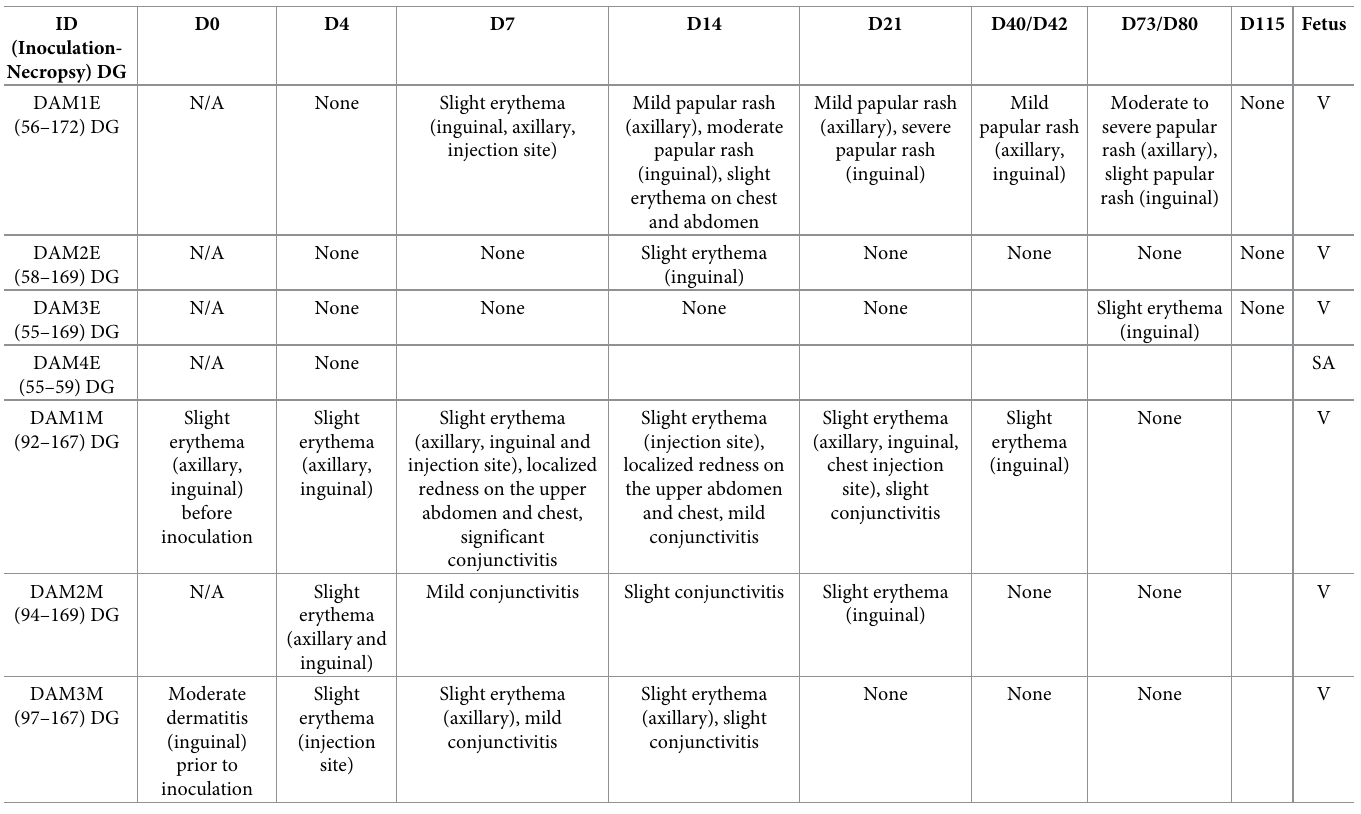
Table 2. Summary of maternal clinical findings and pregnancy